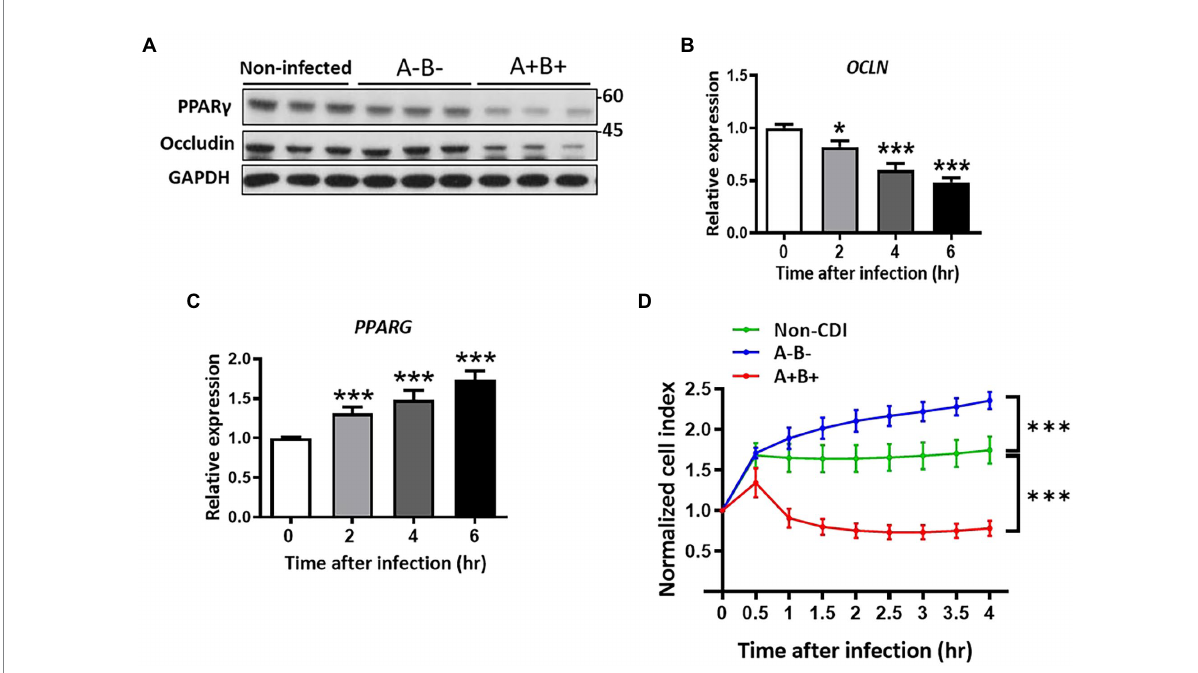
FIGURE 2 Downregulation of PPAR- γ and occludin associated with loss of cell integrity in C. difficile -infected HT-29 cells. Expression of occludin was changed in control and C. difficile JIK 8284 (wild type) and isogenic toxin mutant strain DLL 3121 (A − B − )-infected HT-29 cells. (A) Western blot of PPAR- γ and occludin in HT-29 after 4 h postinfection. (B) Real-time PCR of occludin expression at the indicated time points. (C) Real-time PCR of PPAR- γ expression at the indicated time points. (D) Dynamic impedance-based monitoring of CDI-induced epithelial barrier dysfunction in HT-29 cells, which were infected with or without C. difficile . All values are normalized to the value of untreated cells and expressed as mean ± SEM (*, p < 0.05; **, p < 0.01; ***, p < 0.001 relative to control group). All data are representative of three independent